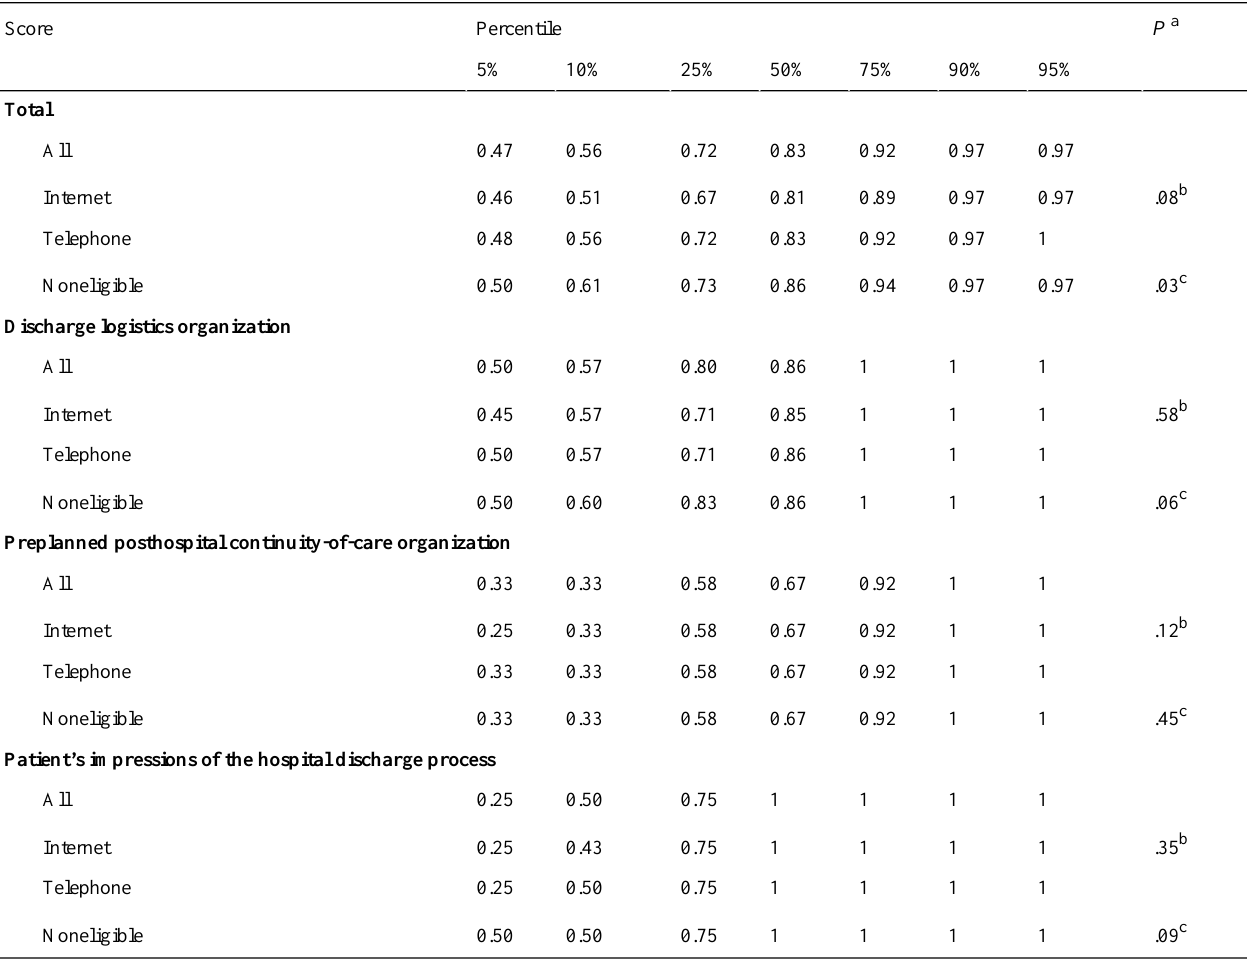
Table 3. Distribution of satisfaction scores (percentiles) of the 755 responders with a hospital stay of 2 or more days according to group.